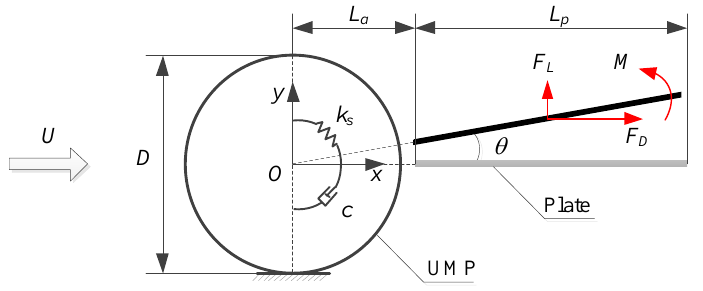
Figure 2. Components of the FIVEC: ( a ) general view and ( b ) inside view.